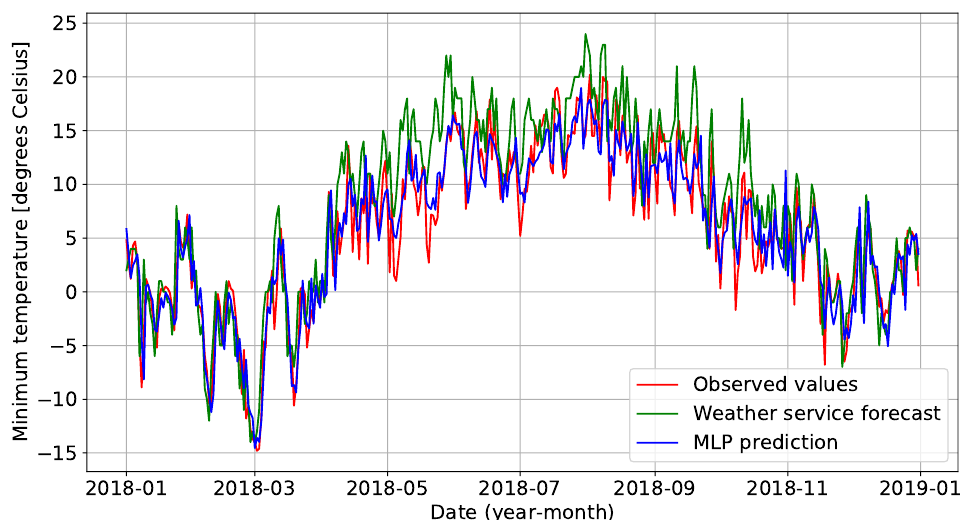
Figure 4. Comparison between the observed values and those predicted by the MLP and weather service minimum